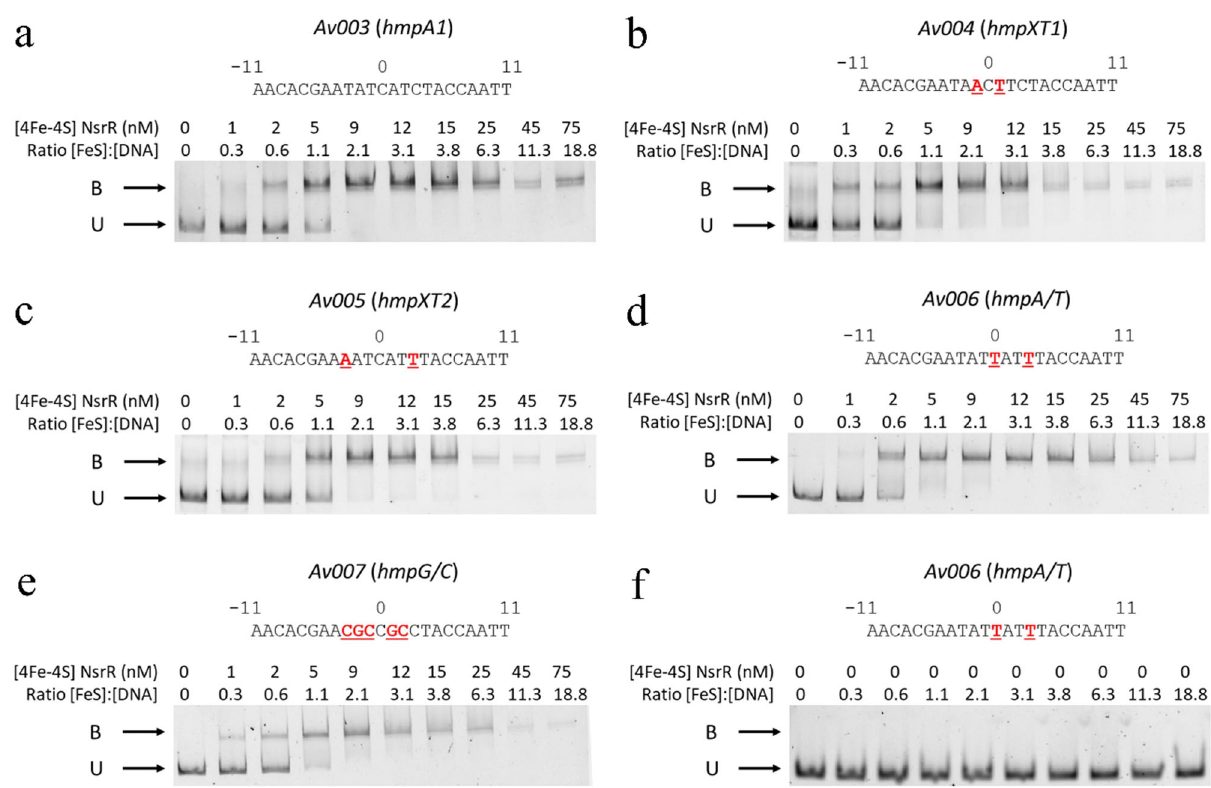
Fig. 7 Binding of NsrR to modi fi ed probes. DNA binding EMSAs showing probes (Av003 – Av007) unbound (U) or bound (B) by [4Fe-4S] NsrR. Probes contain: a Wild type hmpA1 operator, b hmpXT1 , c hmpXT2 , d hmpA/T , e hmpG/C sequences, f Protein-free control for hmpA/T . Base sequences for each probe are shown, with changes relative to the wild type hmpA1 site shown in red. The DNA concentration was ~4 nM. Concentration of [4Fe-4S] NsrR used and ratios of [4Fe-4S] NsrR to DNA are indicated. The binding buffer contained 10 mM Tris, 54 mM KCl, 0.3% (v/v) glycerol, 1.32 mM GSH, pH